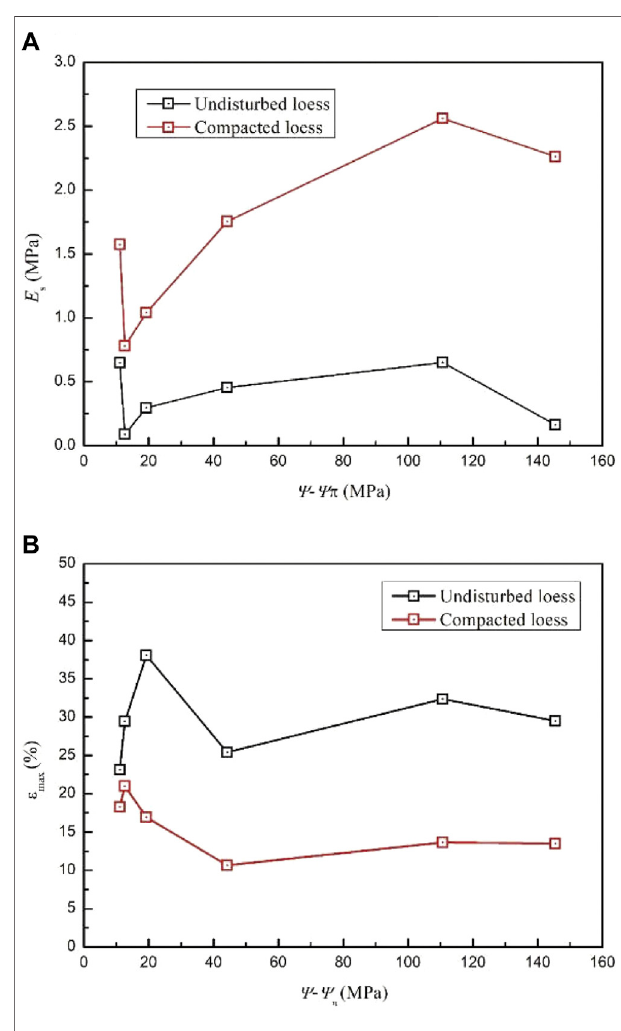
FIGURE 10 | The compression modulus and ultimate strain changed with Ψ - Ψ π : (A) E s versus Ψ - Ψ π ; (B) ε max versus Ψ - Ψ π